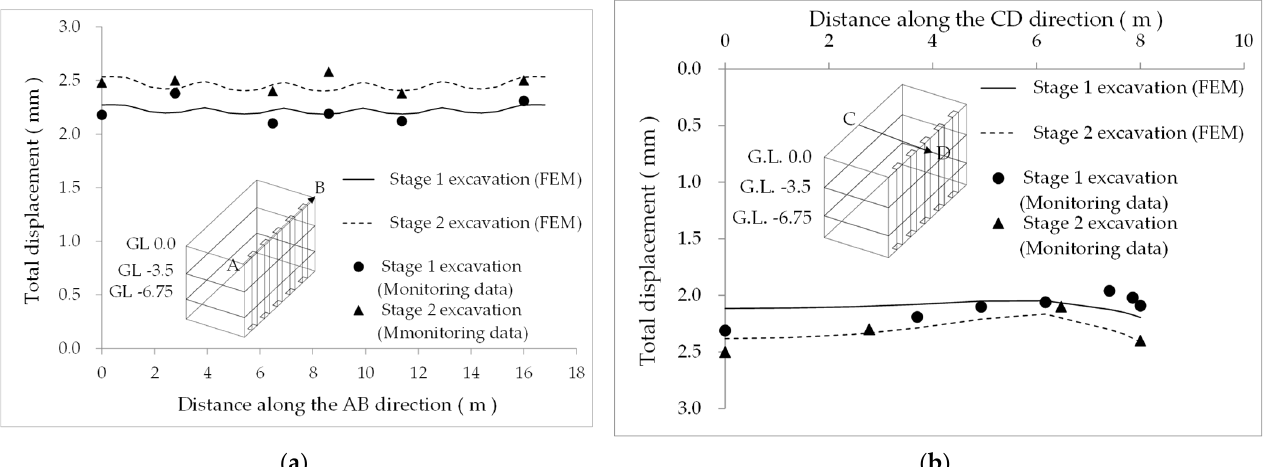
Figure 14. Comparison of 3D FEM analysis results with the monitoring data on railway track subsidence (SR) for the total displacement of the excavation in stages 1 and 2: ( a ) along the AB direction; ( b ) along the CD direction.